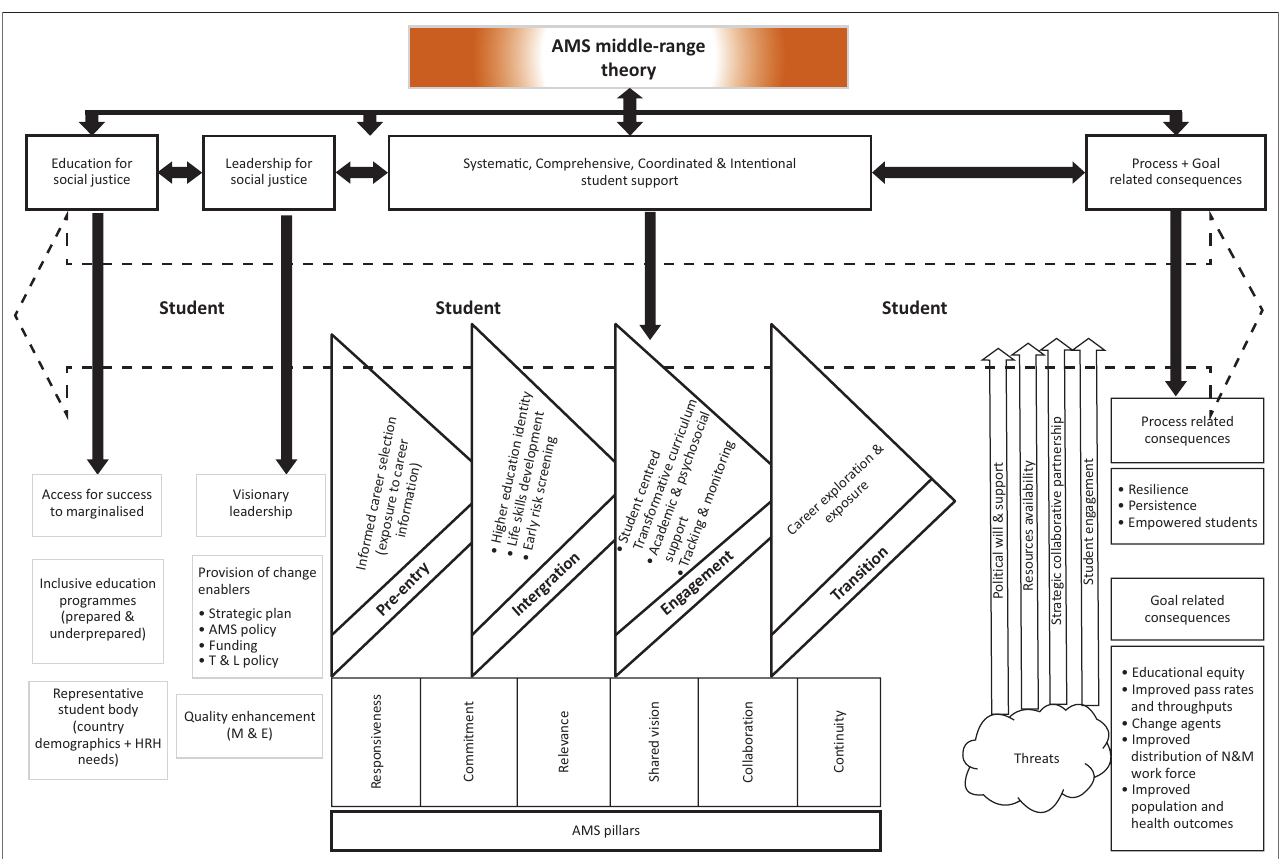
FIGURE 1: Academic monitoring and support middle-range